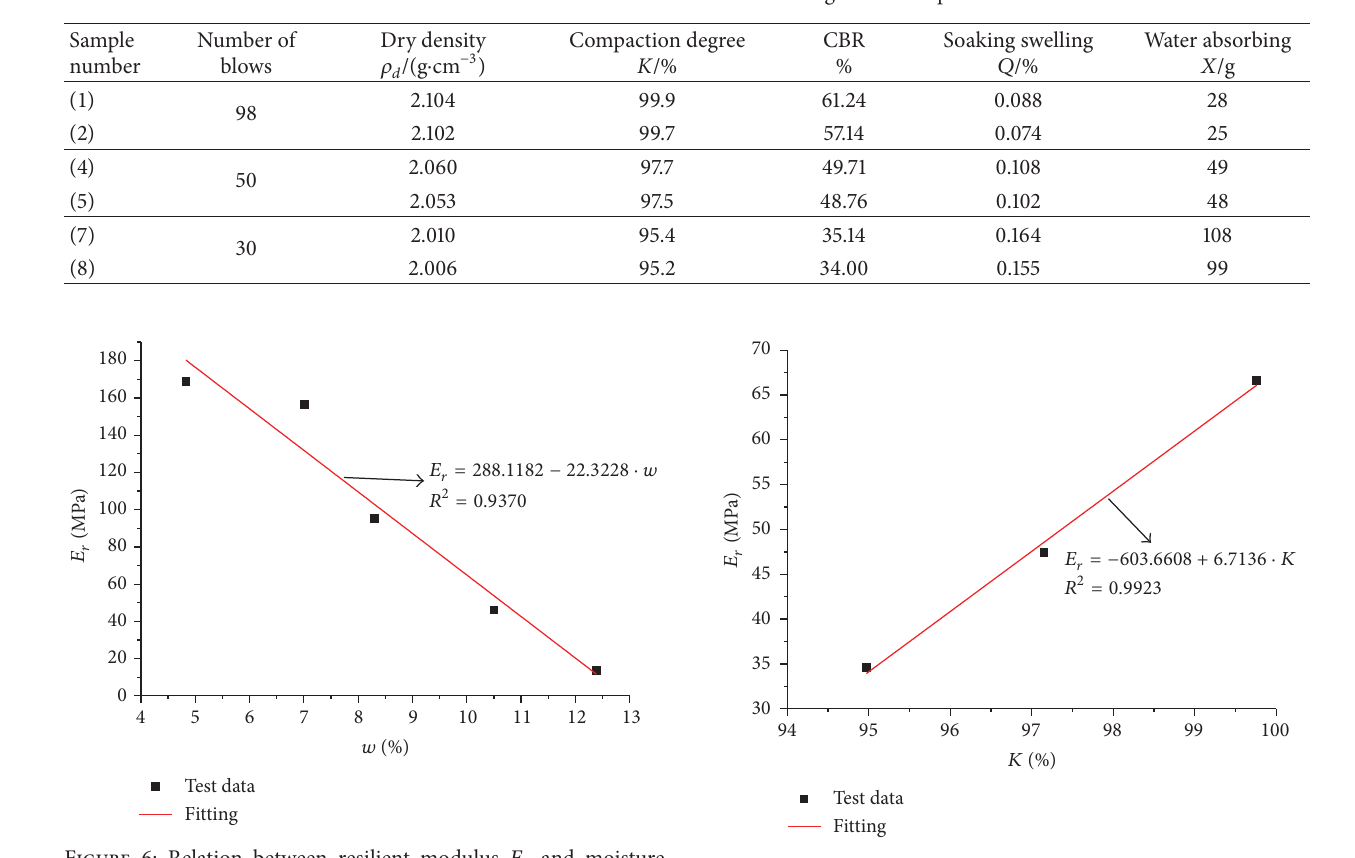
Table 3: The results of CBR tests under different degrees of compaction.